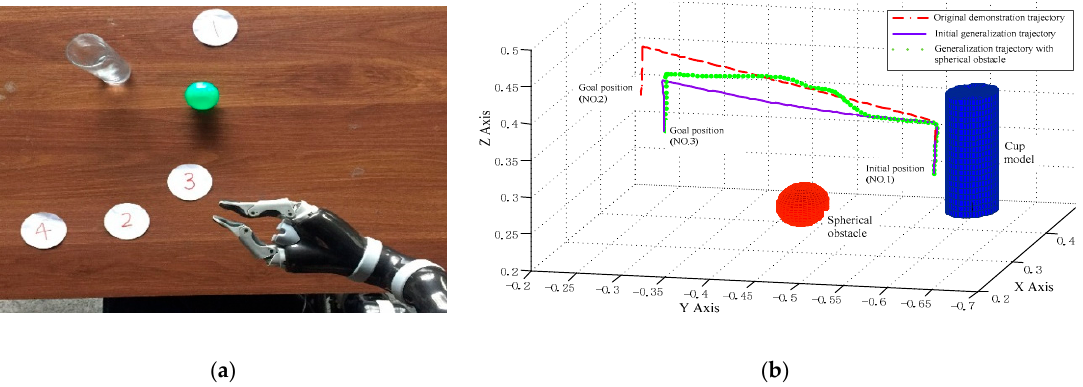
Figure 10. The experiment of placing a cup with a small spherical obstacle: ( a ) initial experiment setting with spherical obstacle; ( b ) generalization trajectory with a spherical obstacle.